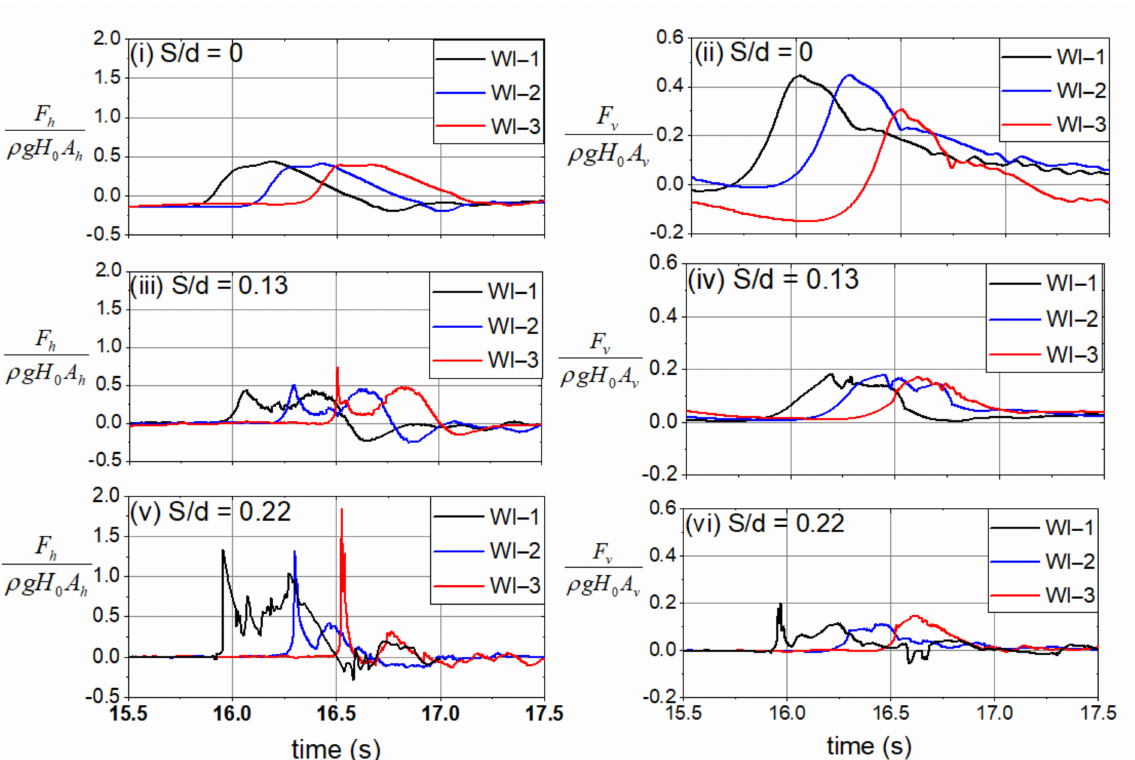
Figure 20. The horizontal ( i , iii , v ) and vertical ( ii , iv , vi ) force time history at three wave breaking scenarios: WI-1, WI-2 and WI-3 at different normalised airgaps ( S/d = 0, 0.13 and 0.22).